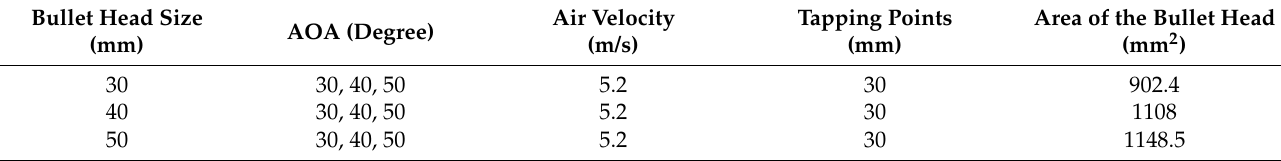
Figure 1. Dimensions ( a ) and geometry ( b ) of the bullet head in design I. Table 1. Conditions of bullet head in design I.